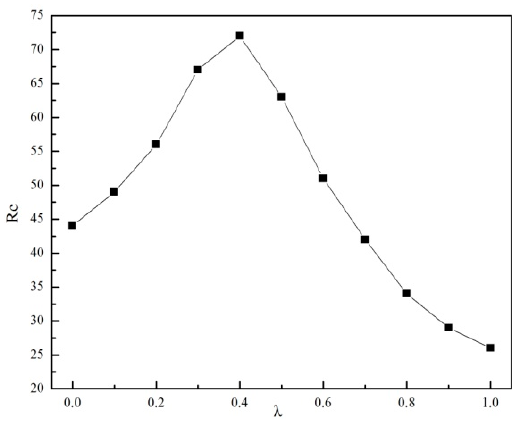
Figure 17. Critical packet generation rate varies vs. I-level packet generation proportion λ .